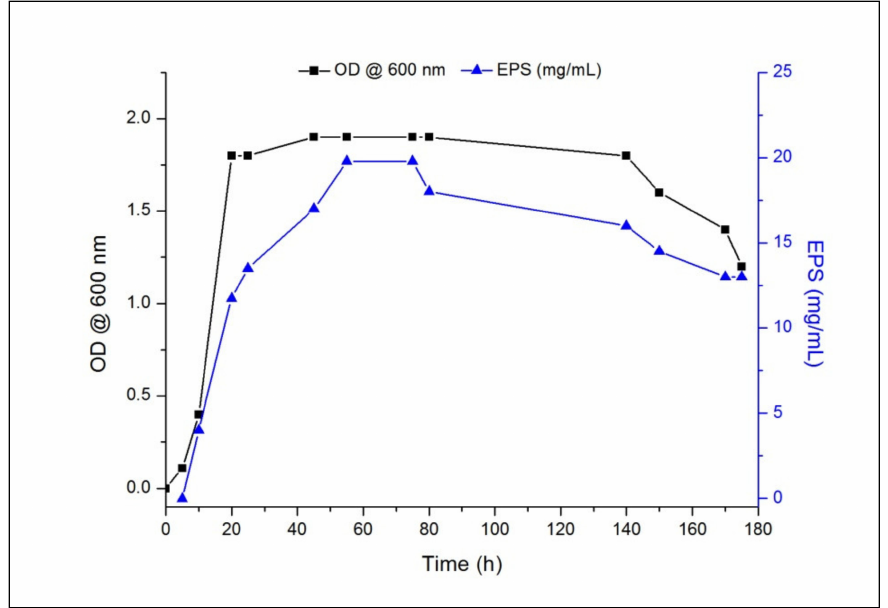
Figure 1. Profile of growth and native exopolysaccharide (nEPS) production by H. desertis in modified MY medium (10% w / v salts, 3% w / v glucose) at 30 ◦ C. ( (cid:4) ), optical density @ 600 nm; ( (cid:78) ), mg EPS per mL of culture